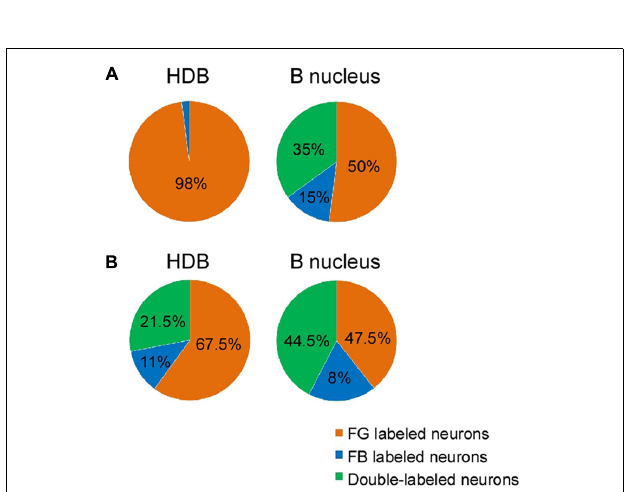
FIGURE 4 | Percentages of single, and double-labeled neurons according to the location of the injection/deposit sites. (A) Graphic representation of normalized relative percentages of FG and FB single neurons, and double-labeled neurons found in HDB and B nucleus after injections in S1/A1 cortices. Note that HDB mainly projects to S1 while the B nucleus projects to both S1 and A1 sensory cortices displaying numerous double-labeled neurons. (B) Graphic representation of FG and FB single neurons, and double-labeled neurons found in HDB and B nucleus after injections in S1/V1 cortices. B nucleus contained a large proportion of double-labeled neurons, indicating a lower specificity in their cortical projections.